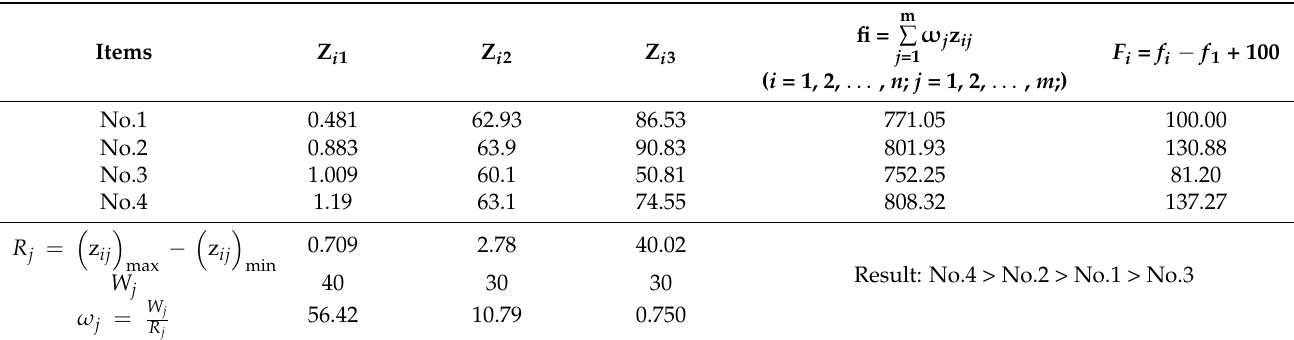
Table 7. Evaluation for acid, self-fluxing, and high-basicity PVTM sinters by the comprehensive